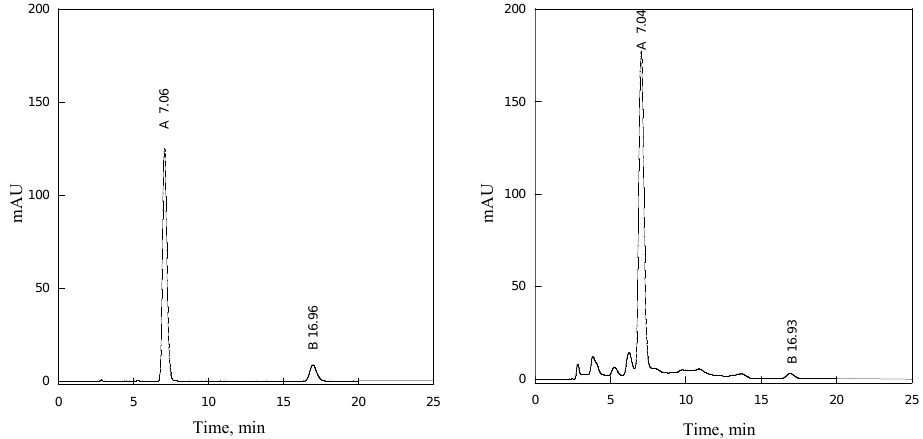
Figure 3. Standard solution chromatogram chromatogram (A: arctiin, B: arctigenin)